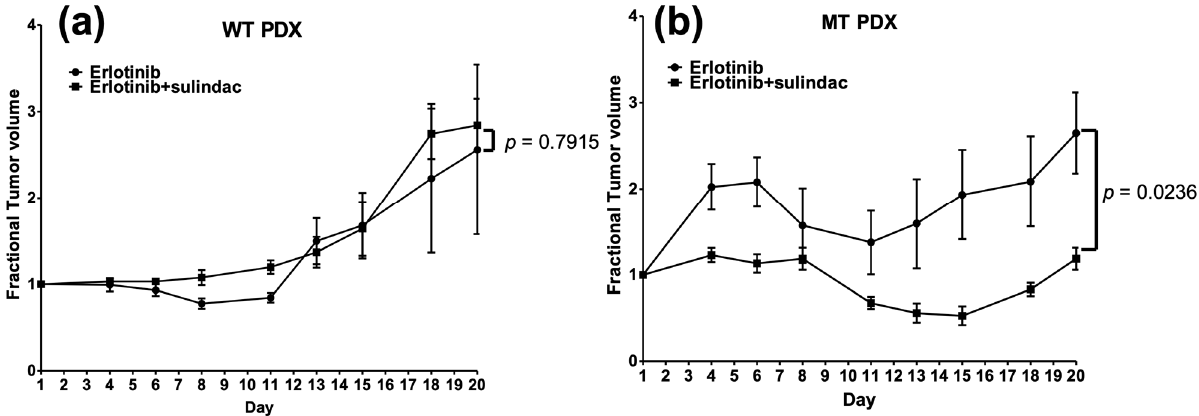
Figure 5. A combination of sulindac with erlotinib potently inhibits tumor growth in PIK3CA -mutant PDX. PDXs were implanted into the flanks of NSG mice and allowed to grow until palpable (n = 4 tumors per group). Mice were then treated with erlotinib (50 mg/kg by oral gavage every day), or the combination of sulindac (30 mg/kg by IP injection every other day) and erlotinib. ( a ) A PIK3CA -WT PDX model does not exhibit significant response to the combination relative to erlotinib alone. ( b ) A PIK3CA -MT PDX model exhibits significant growth inhibition upon the combination of sulindac with erlotinib treatment relative to erlotinib alone. p values were calculated on the last day using two-tailed T-tests with Welch’s correction, as appropriate. Data are displayed as mean ± SEM.